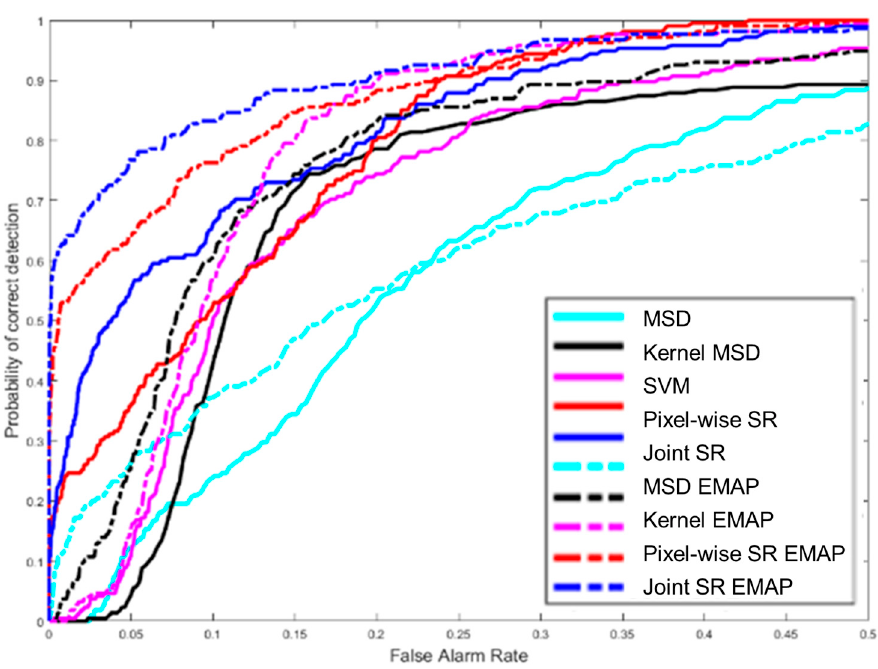
Figure 16. Detection results using synthetic bands.